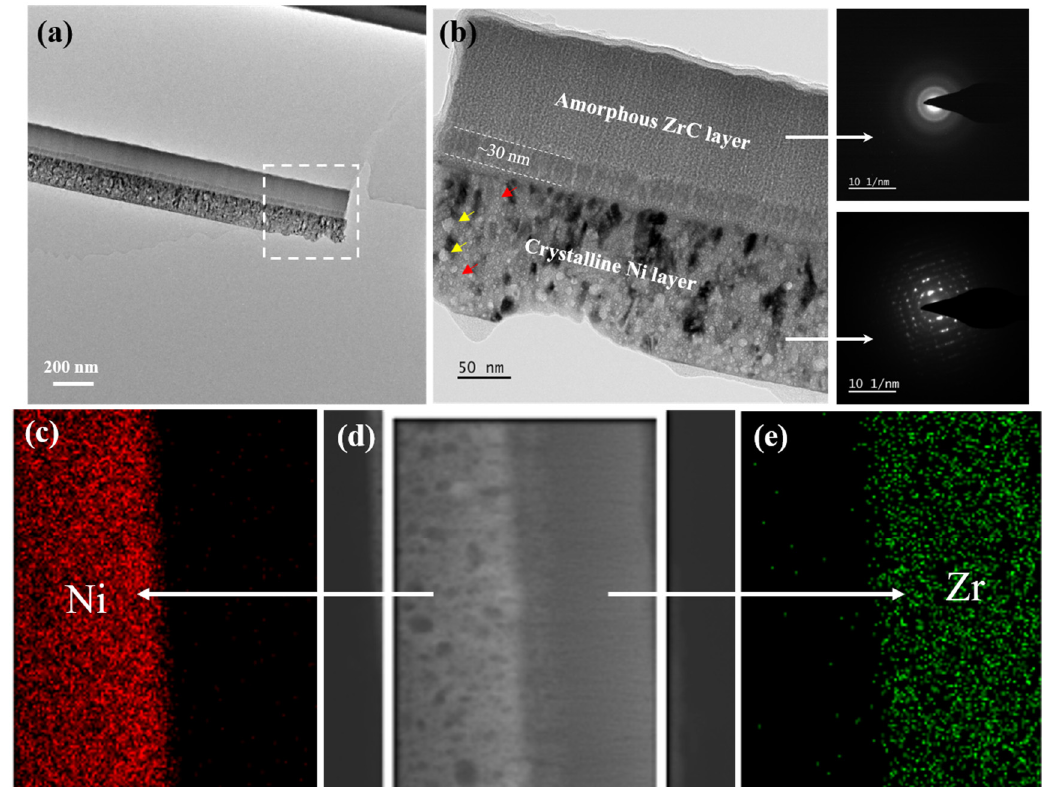
Figure 6. ( a ) Overall topography of the cross-section TEM and ( b ) the bright-field TEM image with corresponding NBED patterns of irradiated amorphous ZrC/nanocrystalline Ni multilayers. ( c , e ) EDS mapping of Zr and Ni after irradiation corresponding to ( d ) STEM image.